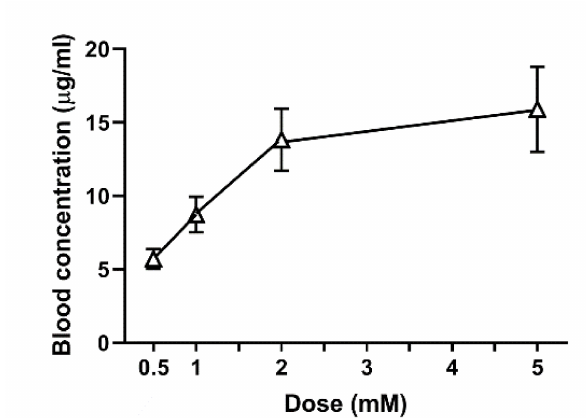
Figure 3. Blood concentrations of felbinac with increasing dose after coating transdermal administration. Each point and vertical bar indicate the mean and SD, respectively. n =